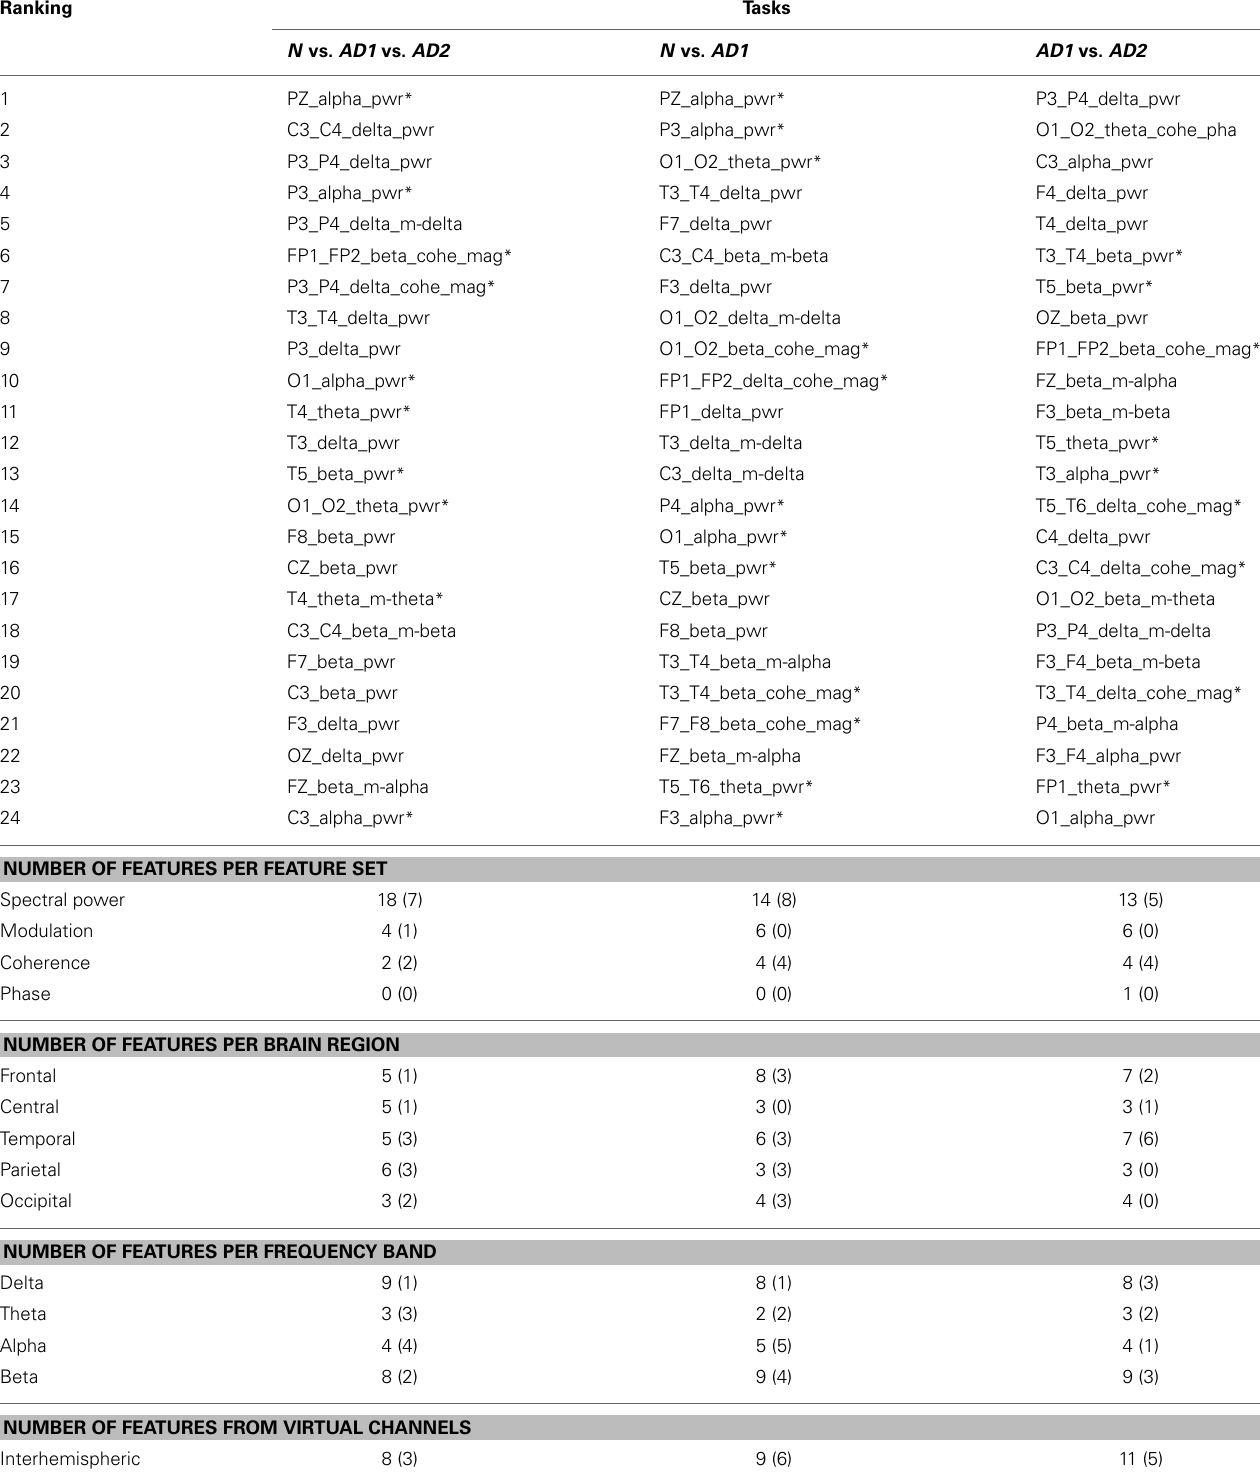
Table 5 | Selected features used with the wICA-AAR automated system. Ranking